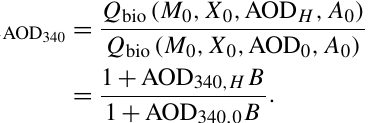
Figure 4. The altitude dependence of aerosol optical depth at 340nm with 1 σ error bar according to the AERONET, LIVAS and the Moscow State University data sets over European and Asian re- gions. May–September period. The AOD at 330nm the Moscow State University data set and the AOD at 355nm from the LI- VAS data sets were recalculated to AOD at λ = 340nm using the Angstrom exponent α = 1 . 0. See further details in the text.